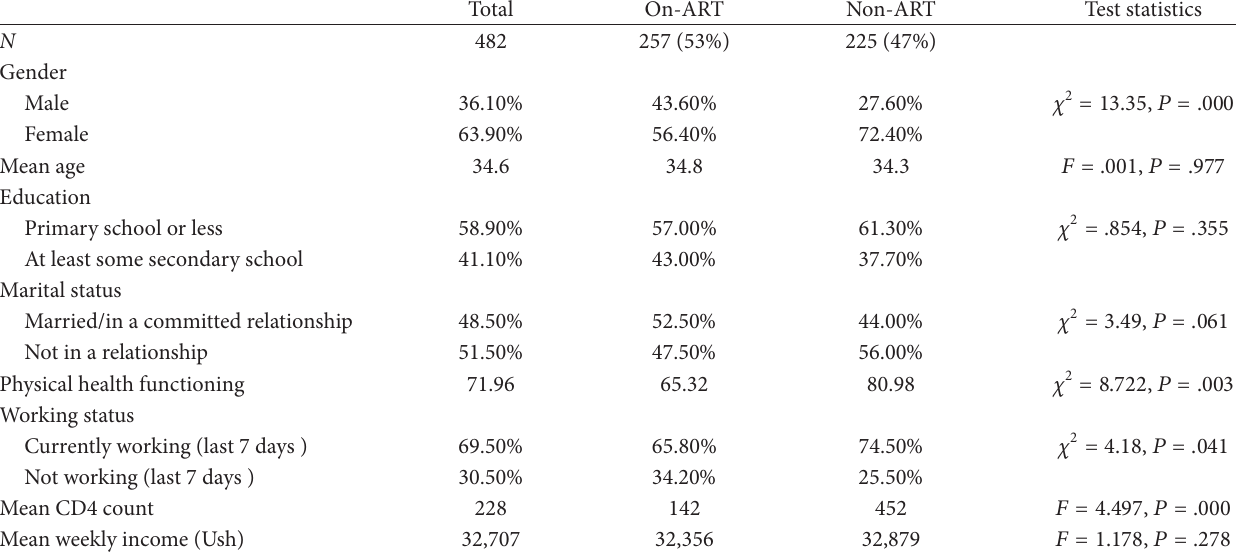
T 1: Baseline demographic, physical health, and economic characteristics of total sample and by ART status (